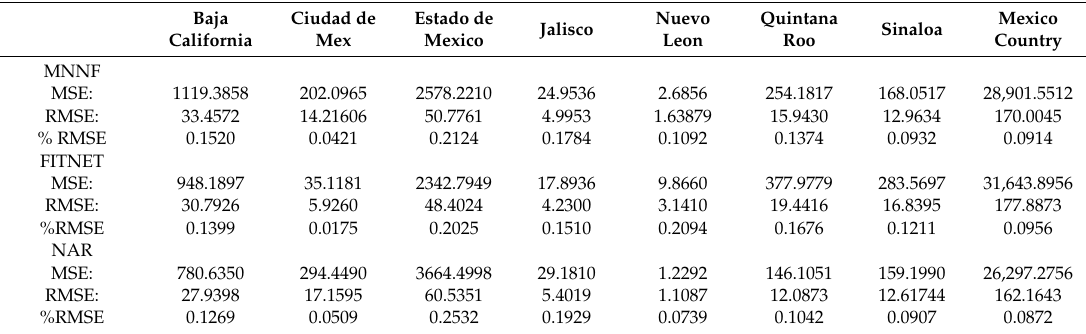
Table 4. Example of % RMSE for the different models for death cases.